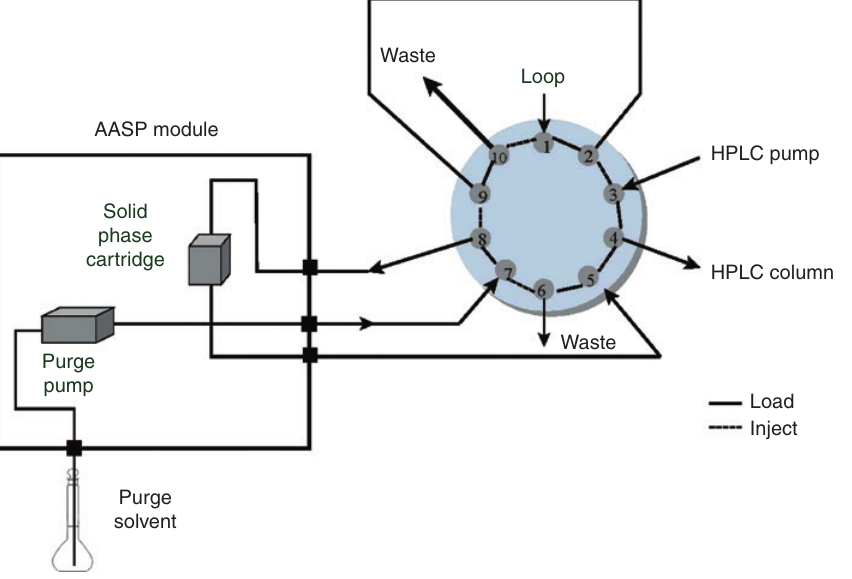
Figure 2: Schematic diagram of the SPE cartridge coupled to a fluorimetric HPLC system to analyze NEO and CREA in serum samples [51]. Reproduced with permission from the American Association for Clinical